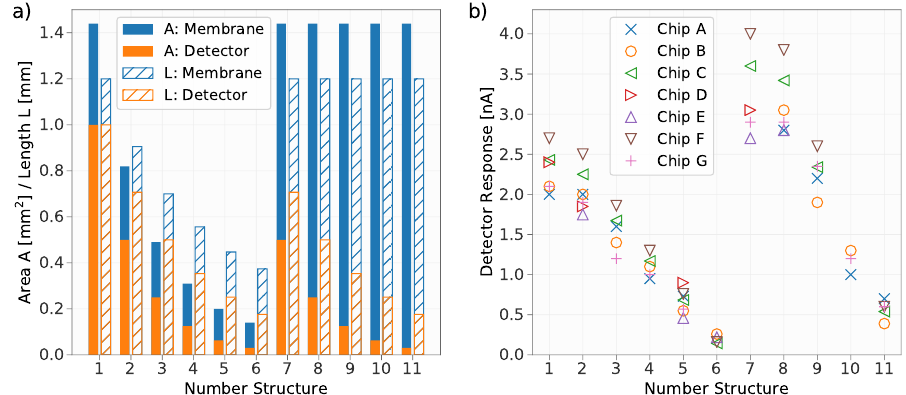
Figure 5. ( a ) The area and the lateral length of the various tested detector designs. Both the detector and the membrane are quadratic. ( b ) The generated current of the investigated detectors when irradiated with a power of 11mW at a wavelength of 4.17 µ m and modulated at a frequency of